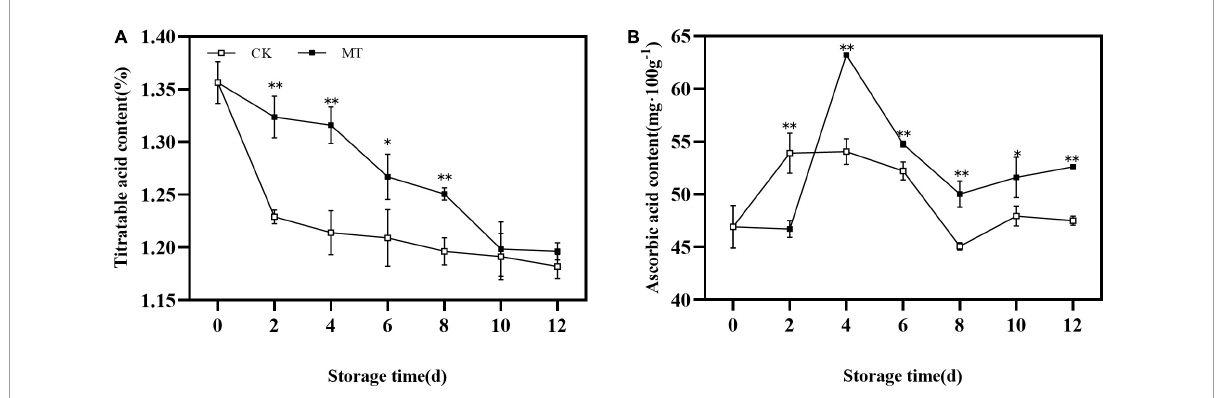
FIGURE3 Effects of melatonin (MT) treatment on the titratable acid (TA) (A) and ascorbic acid content (B) of ‘Jinyan’ kiwifruit. Data represent the means ± SE ( n = 3). Asterisks indicate significant differences between the control and MT treatments ( ∗ P < 0.05; ∗∗ P <